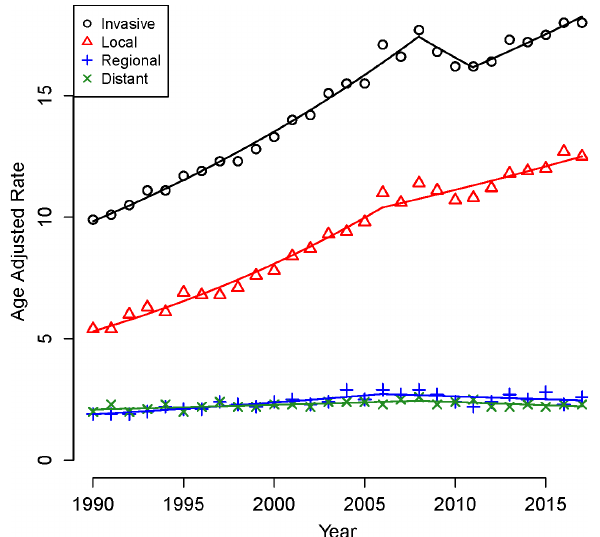
Figure 3: Race-stratified, age-adjusted rates of RCC per 100,000